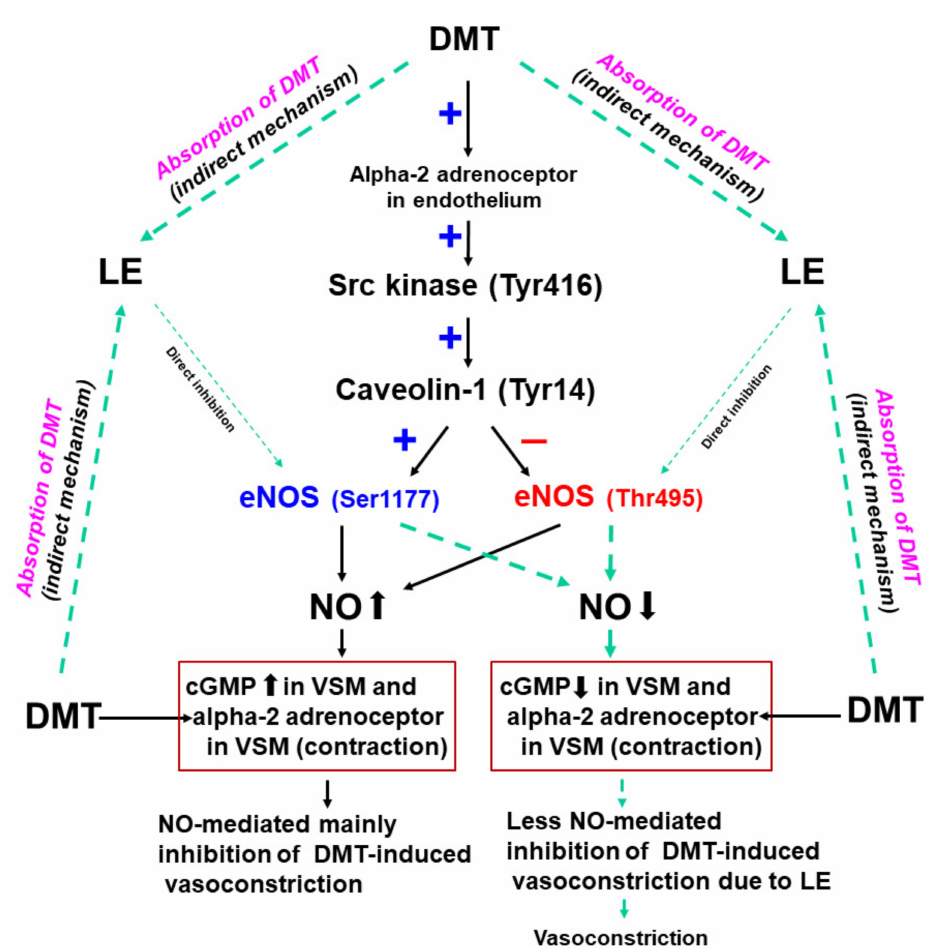
Figure 10. The putative cellular signal pathway associated with lipid emulsion (LE)-mediated enhancement of dexmedeto- midine (DMT)-induced contraction of the rat aorta. As DMT-induced endothelial nitric oxide (NO)–mediated vasodilation of the aorta is prominently dominant compared with the DMT-induced vasoconstriction of the vascular smooth muscle (VSM), LE-mediated relatively less inhibition of the DMT-induced contraction leading to vasoconstriction, seems to be associated with the reduced amount of DMT available to endothelial alpha-2 adrenoceptor via absorption of DMT by LE. The DMT-induced NO production is due to the increased stimulatory endothelial nitric oxide synthase (eNOS Ser1177) phosphorylation and decreased inhibitory eNOS (Thr495) phosphorylation, which is mediated by the pathway involving alpha-2 adrenoceptor, Src kinase and caveolin-1. cGMP: cyclic guanosine monophosphate; +: stimulation, − :